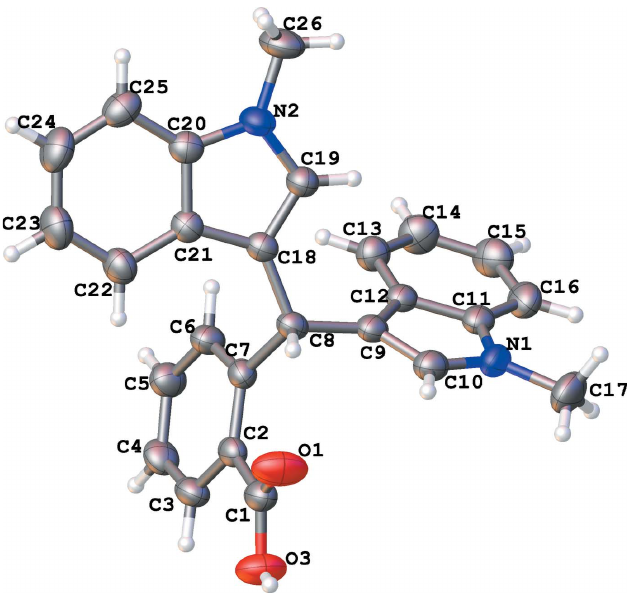
Figure 3 View of the Hirshfeld surface of the title compound mapped over d norm in the range (cid:4) 0.68 to +1.45 au.